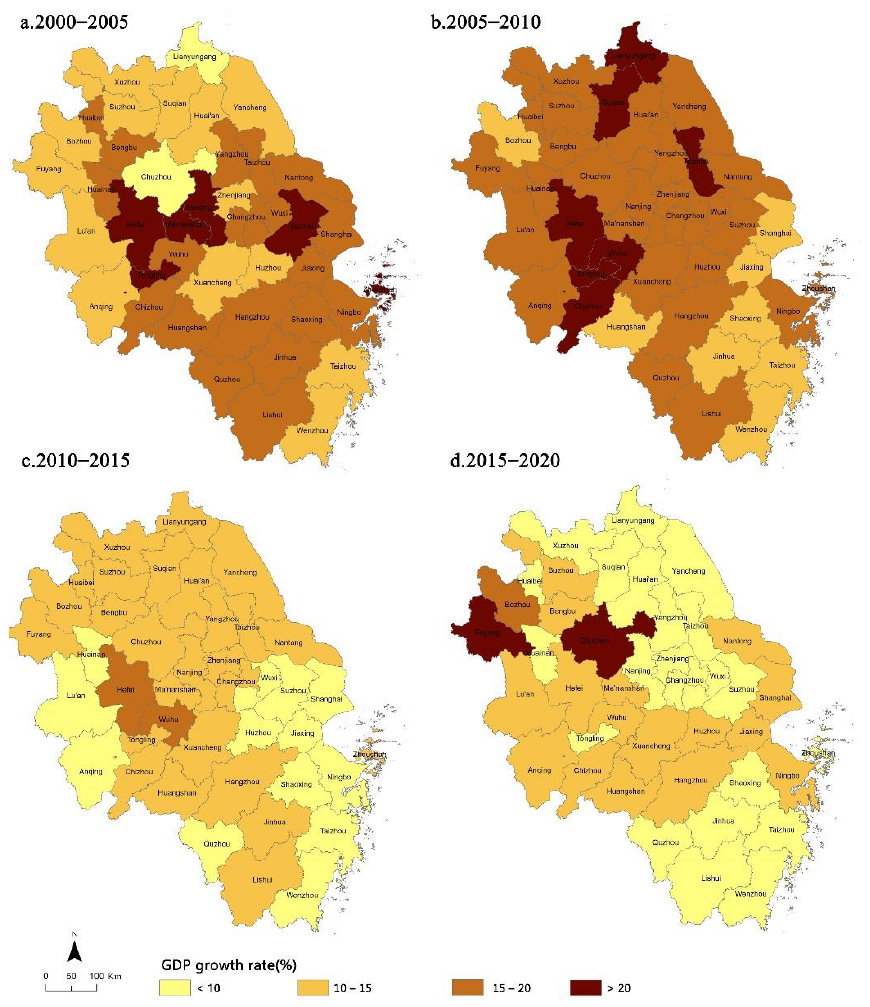
Figure 3. GDP growth rate of cities in the YRD during 2000 – 2020.